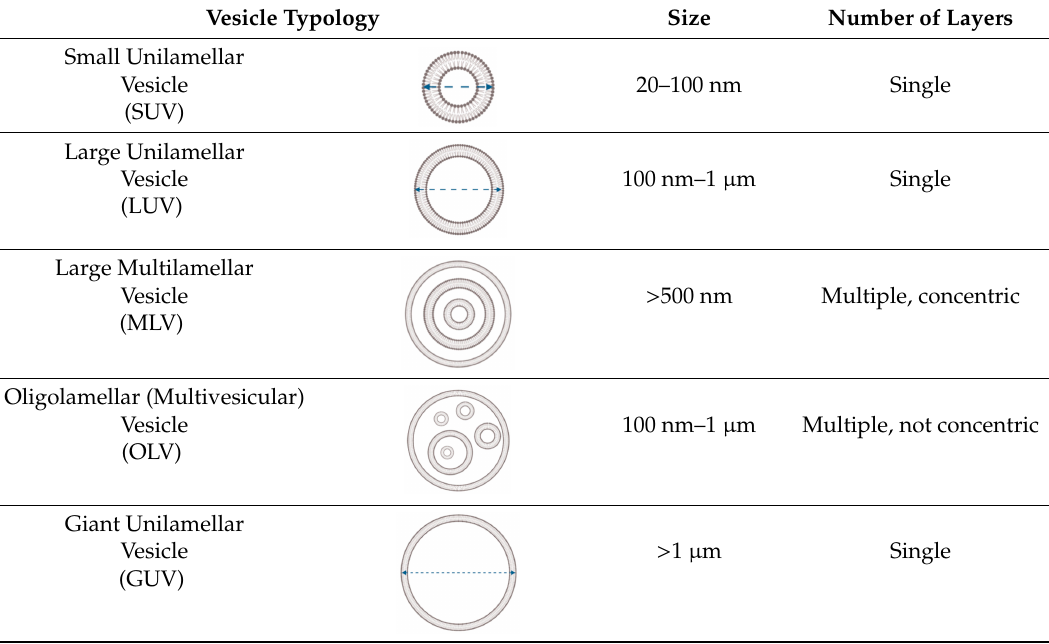
Table 1. Scheme of liposome classification.